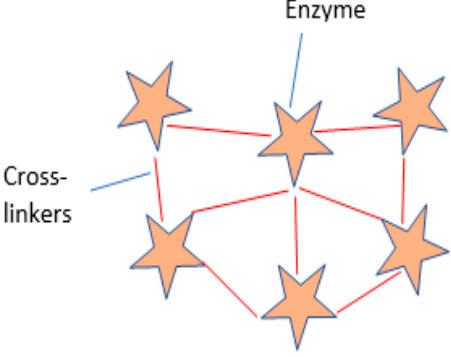
Figure 6. Enzyme immobilisation by cross-linking method.